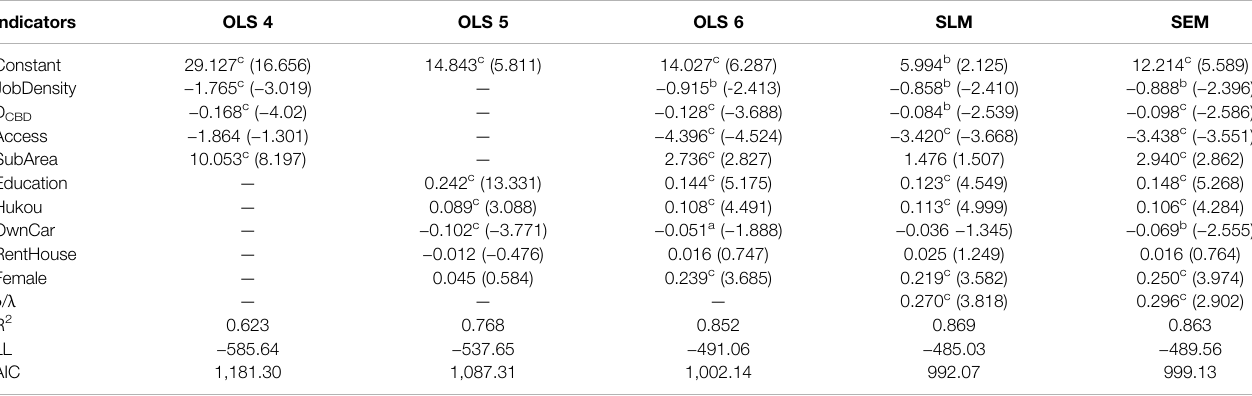
TABLE 3 | Model results of commuting duration.